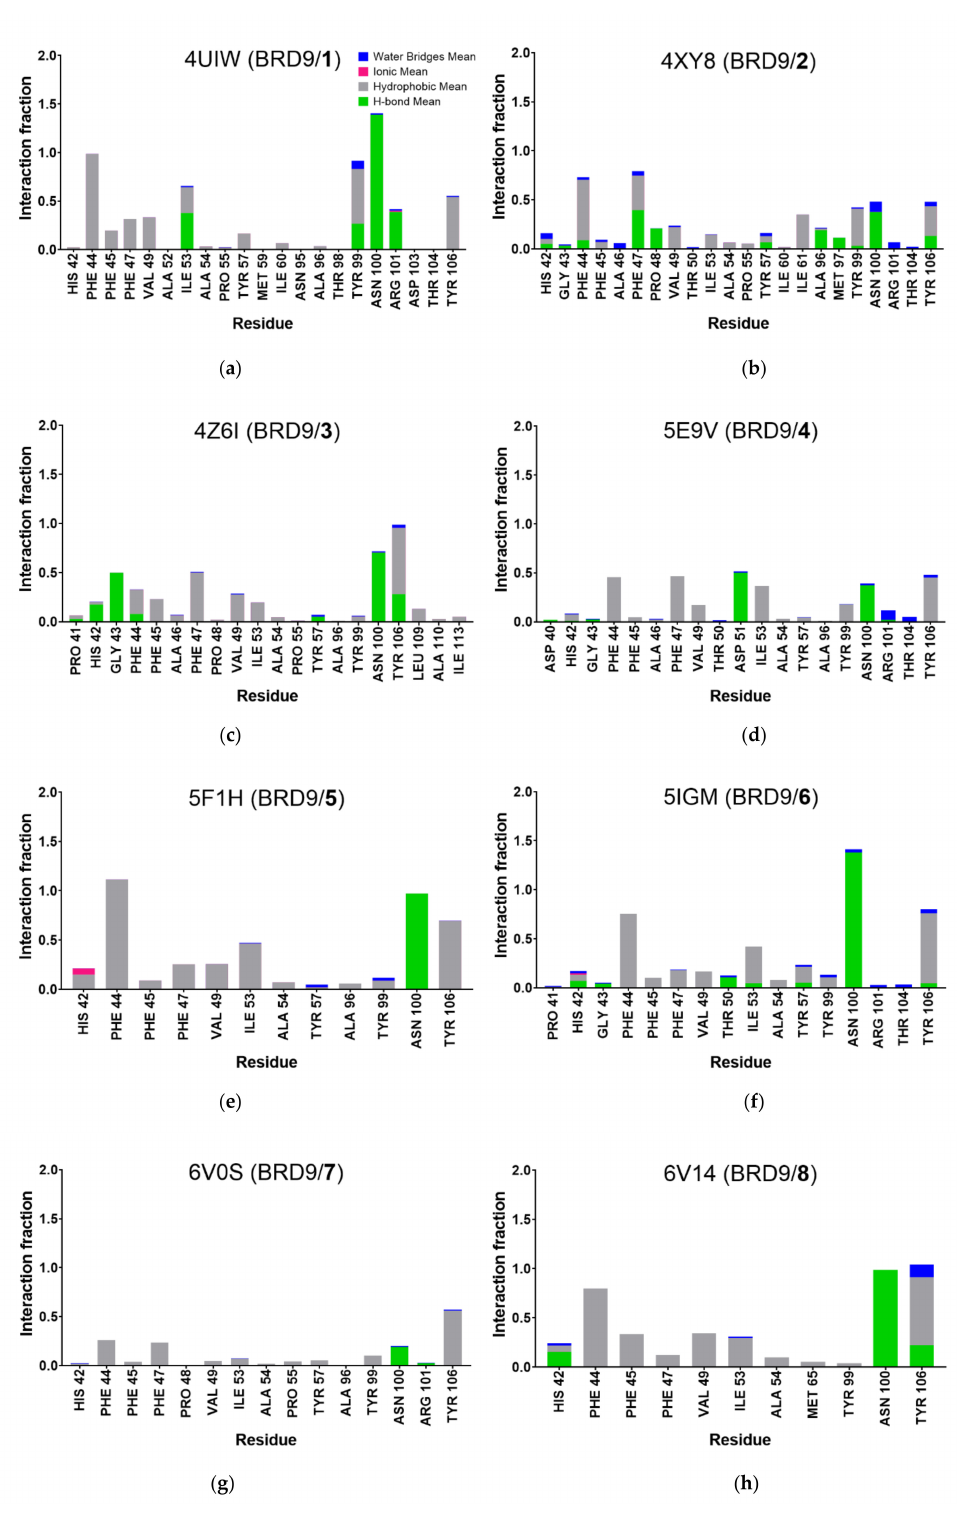
Figure 8. ( a – h ) Protein-ligand interactions of each ligand/protein complex. Values reported are the mean of the three replicated MDs and they are expressed as the fraction of total time. Values above 1.0 are due to the cumulative effect of the various type of interactions, specifically for ( a ) 4UIW, ( b ) 4XYZ, ( c ) 4Z6I, ( d ) 5E9V, ( e ) 5F1H, ( f ) 5IGM, ( g ) 6V0S, ( h ) 6V14. As expected, compounds 1 and 5 showed a strong interaction pattern with the binding site amino acids while 7 made irrelevant contacts with the protein counterpart, in contrast with what could be hypothesized from the RMSD and RMSF analysis. The strong